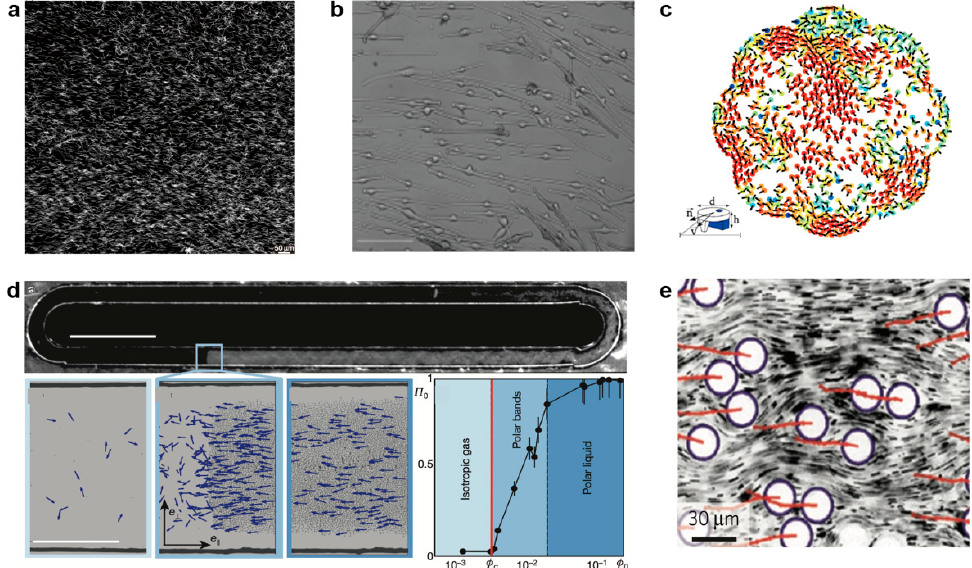
Figure 2. The existence of long-range order in microscopic active systems. ( a ) Nematically ordered phase in a thin fluid layer of filamentous bacteria at high density. Reproduced with permission from [36]. ( b ) Long-range oriented human melanocytes cells. Scale bar, 100 µ m. Reproduced with permission from [38]. ( c ) Collective motion of self-propelled disks; bottom left panel: a sketch of the polar disk with diameter d = 4 mm. Reproduced with permission from [39]. ( d ) Top: dark-field images of roller particles that spontaneously form a microscopic band propagating along the channel. Scale bar, 5 mm. Bottom images show enlarged views of different phase: isotropic gas; polar bands; polar liquid. Scale bar, 500 µ m. Reproduced with permission from [40]. ( e ) The microfluidic 2D droplet ensemble and velocity fluctuations. Reproduced with permission from